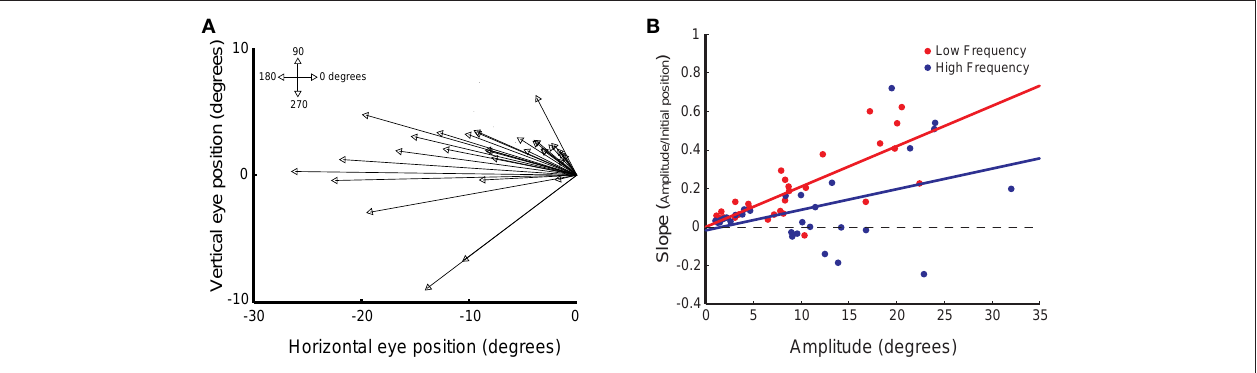
position as a function of mean horizontal saccade amplitude, for each stimulation site and frequency level. Data are shown for low (red) and high (blue) frequency stimulation conditions. Each data point represents a single stimulation site and frequency level. Lines show linear regression through the data.